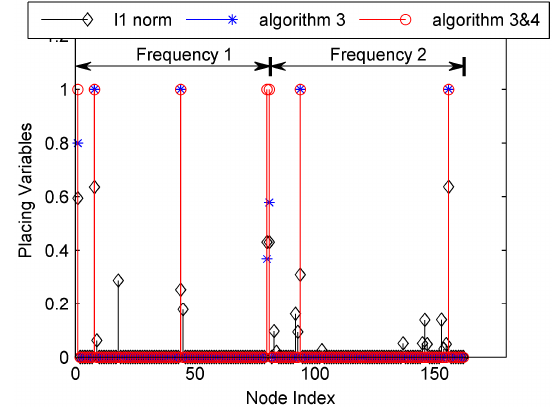
Figure 3. The solutions of (13) using three methods.